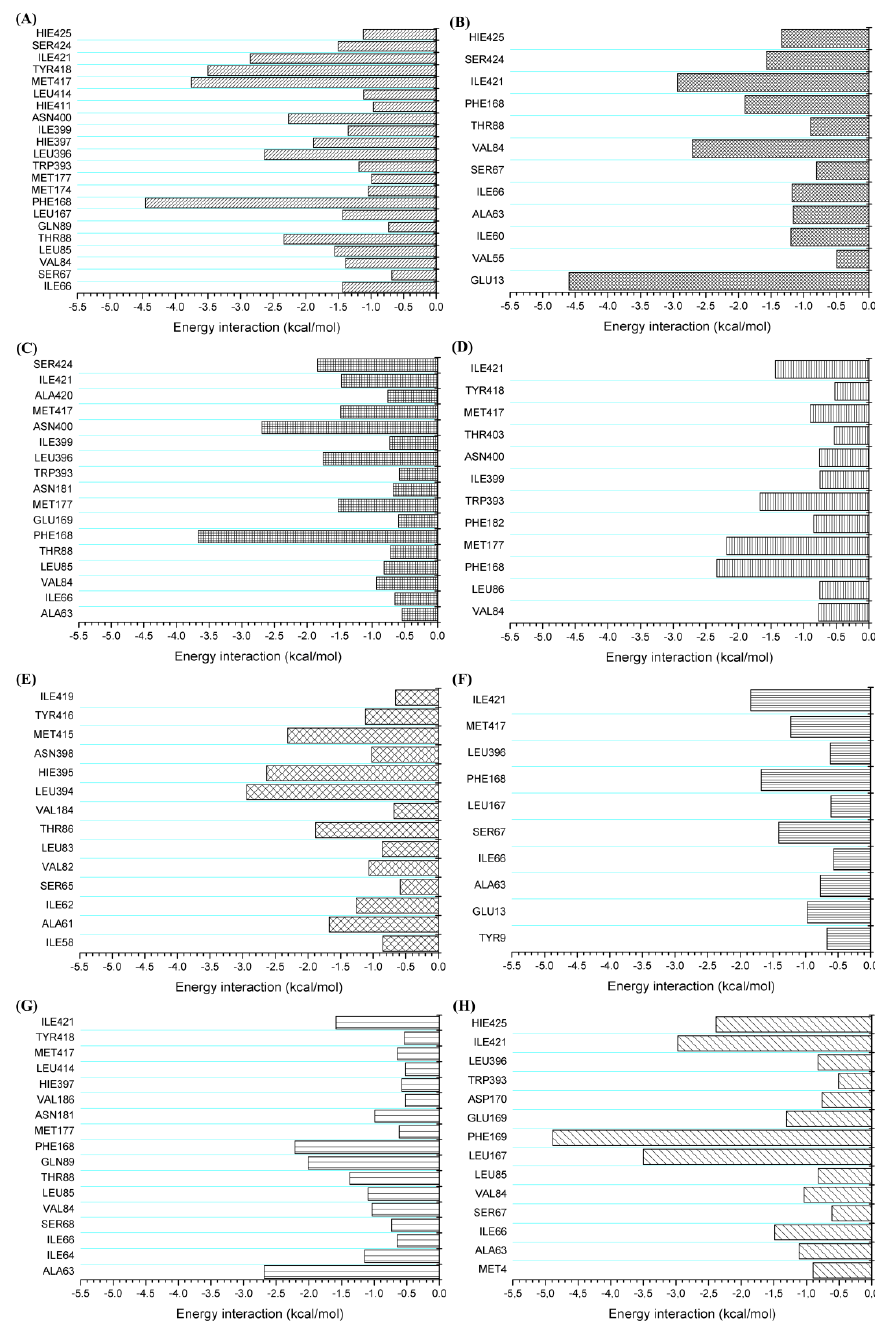
Figure 13. Per-residue free energy decomposition of complexes established between A 2A receptor and ligands ( A ) UK- 432097, ( B ) Regadenoson, ( C ) ZINC00000416, ( D ) 10002403, ( E ) 5193875, ( F ) 6942649, ( G ) 7928320 and ( H ) ZINC4257548 system.